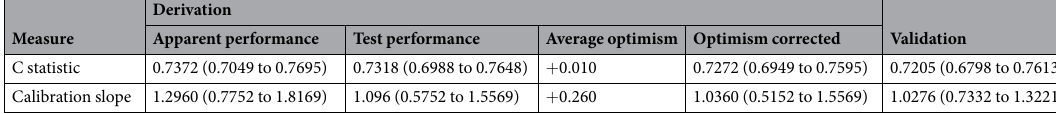
Table 3. Model diagnostics (with 95%